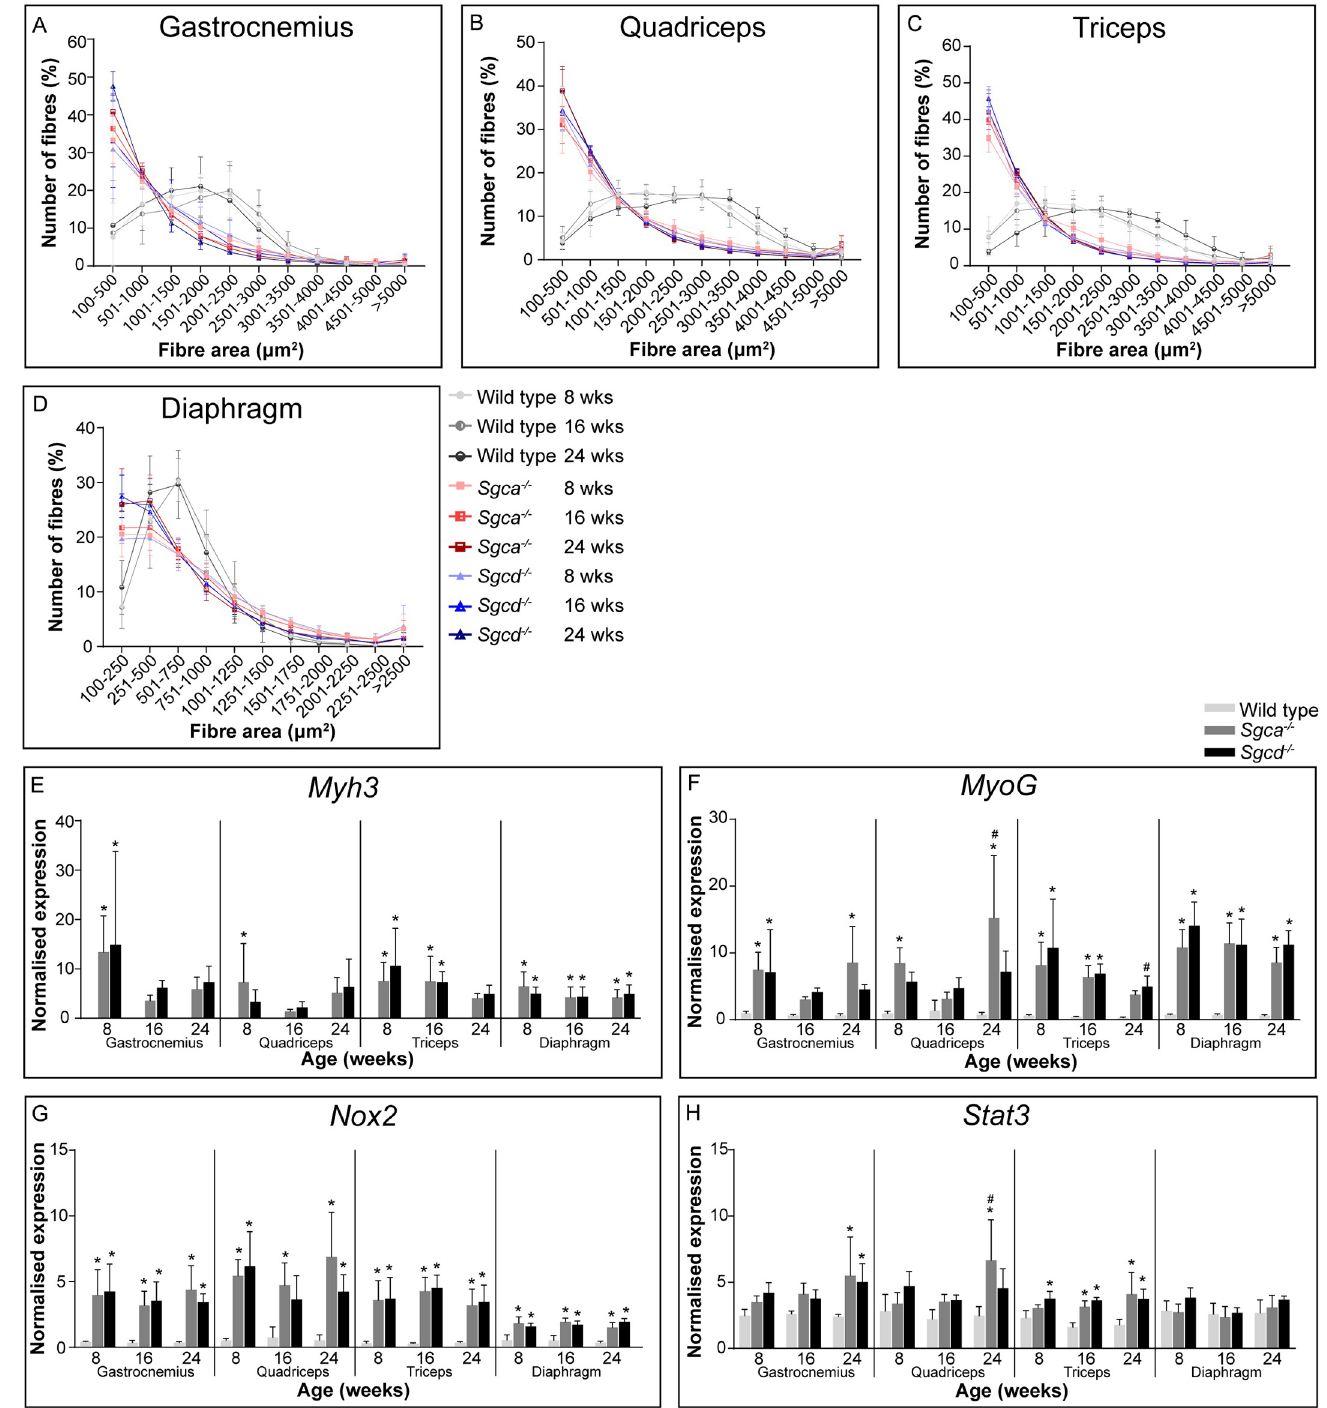
Fig 4. Regeneration in Sgca -/- and Sgcd -/- males. (A-D) Muscle fibre area distribution measured by staining with laminin. (E-H) Gene expression of Myh3 (E). Since Myh3 was not detectable in wild type mice, values were put at zero. MyoG (F), Nox2 (G) and Stat3 (H). N = 5-6 male mice per group. � p < 0.05 vs age-matched wild type mice, # p < 0.05 over time (same